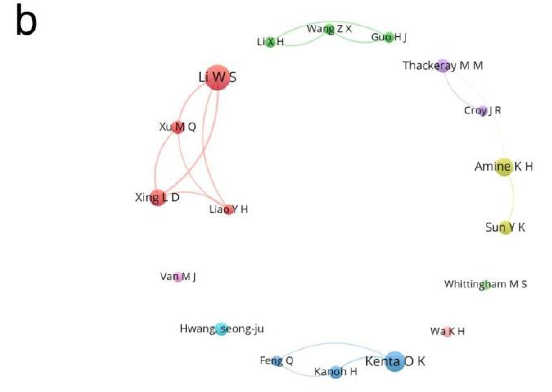
Figure 4. Spent lithium-ion battery recycling issued between the author contacts: ( a ) author co- operation relationships and ( b ) author clustering analysis.